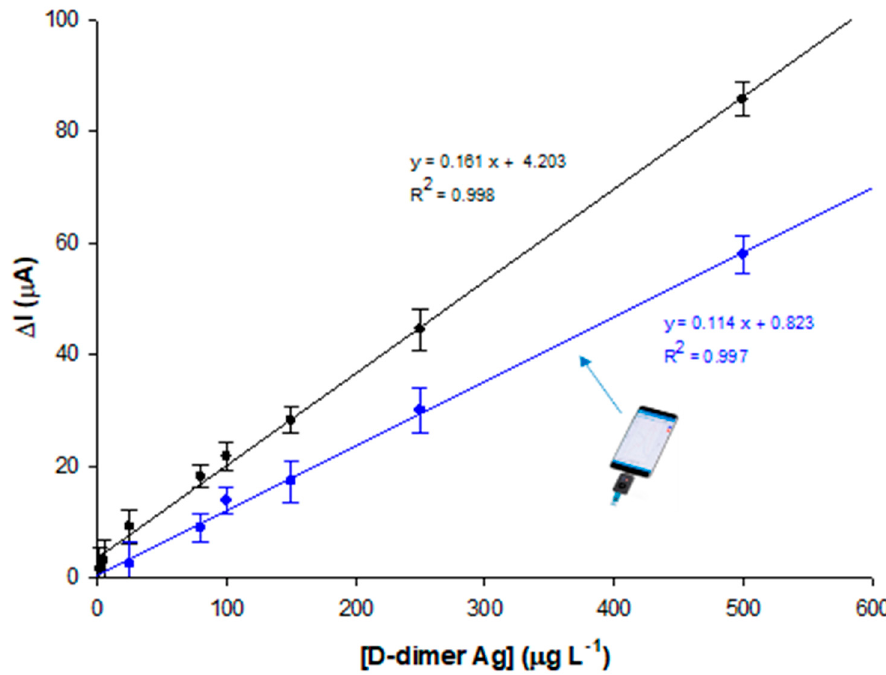
Figure 5. Calibration plot for different D-dimer concentrations (2, 5, 25, 80, 100, 150, 250, and 500 µ g L − 1 in PBS pH 7.4) with Autolab PGSTAT potentiostat (black curve) and Sensit Smart portable potentiostat (blue curve). Experimental conditions: Zobell’s solution; D-dimer antibody = 0.1 μ g mL − 1 . Table 2. Voltammetric immunosensors for D-dimer protein